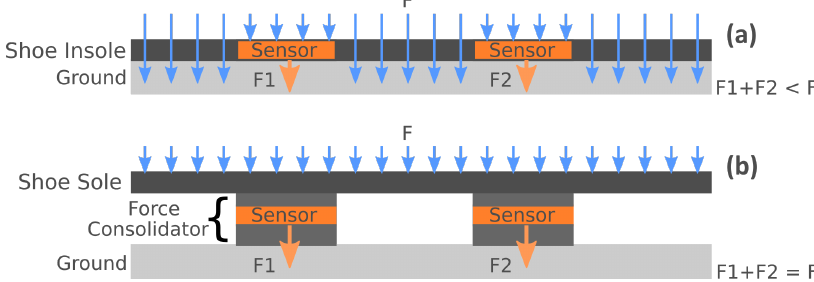
Figure 1. ( a ) Sensors in Shoe Insole ( b ) Sandwiched Sensor Force Consolidators